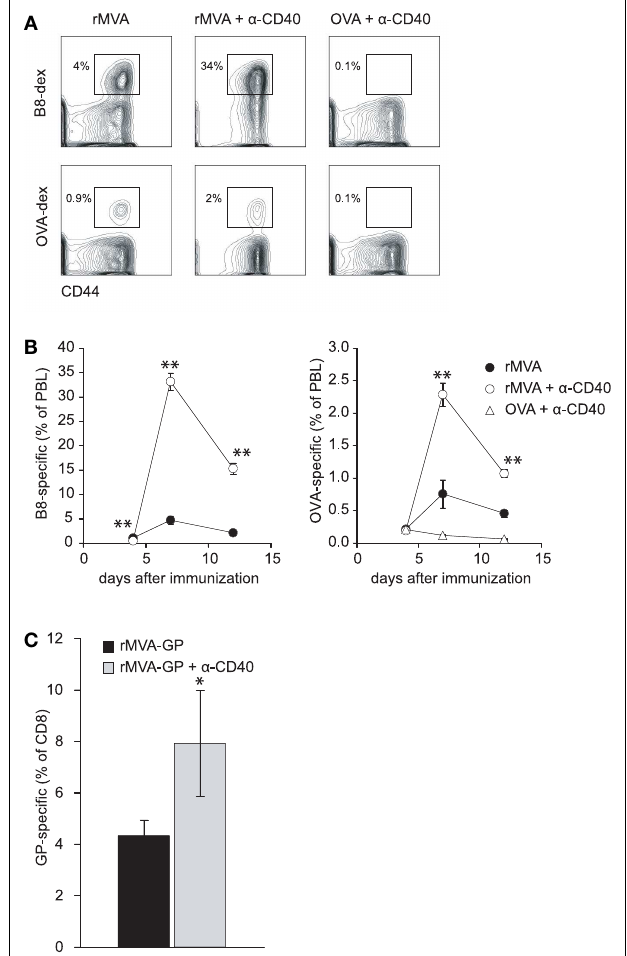
FIGURE 1 | CD40 co-stimulation increases CTL responses to rMVA encoded antigens but not to a protein antigen . C57BL/6 mice were immunized with rMVA, rMVA + anti-CD40 mAb, or OVA protein + anti-CD40 mAb. B8- and OVA-specific CD8T cells were visualized by MHC class I dextramer staining. (A) Density plots illustrate the frequency of B8- and OVA-specific CTL in the blood on day 7 (gated on CD8 + PBL). Numbers indicate the percentage of CD8 + dextramer + T cells among PBL. A kinetic analysis of B8- and OVA-specific CTLs is shown in (B) . CTL responses to B8 and OVA were drastically enhanced by co-injection of rMVA and anti-CD40 mAb. Note, that no detectable CTL response was generated after immunization with OVA protein and anti-CD40 antibody. (C) Similar to the above described experiment, CBA/J (H-2k) mice were immunized with rMVA-GP encoding the glycoprotein of Zaire Ebola virus ± anti-CD40 mAb. The GP-specific CD8T cell response was measured 7days later by intracellular cytokine staining. Shown is the mean percentage ± SEM of IFN- γ + GP-specific CD8T cells in the spleen. Data are representative of four mice per group.